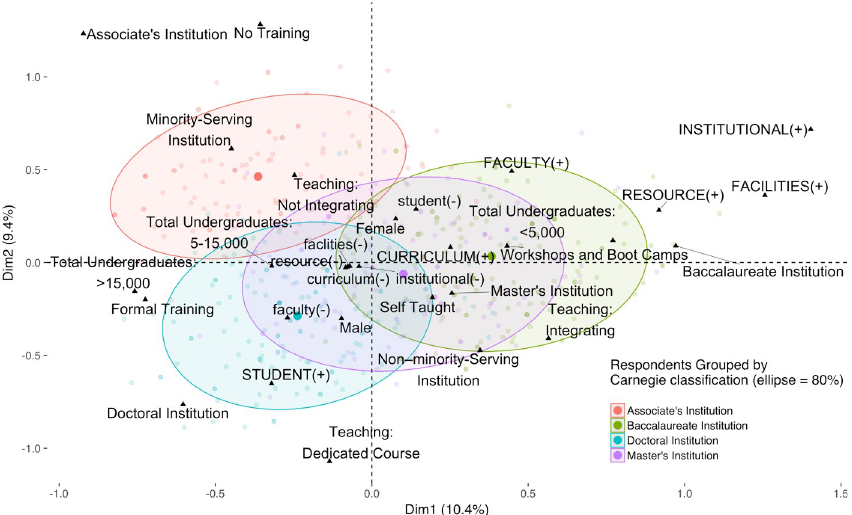
Fig 8. Multiple correspondence analysis of responses stratified by Carnegie Classification. Multiple correspondence was calculated grouping faculty by institutional Carnegie Classification (see Fig 5 and Materials and Methods). As mentioned in the narrative, the figure shows that faculty at associate’s-granting institutions are different from other institutions in a number of key aspects with respect to barriers to inclusion of bioinformatics in